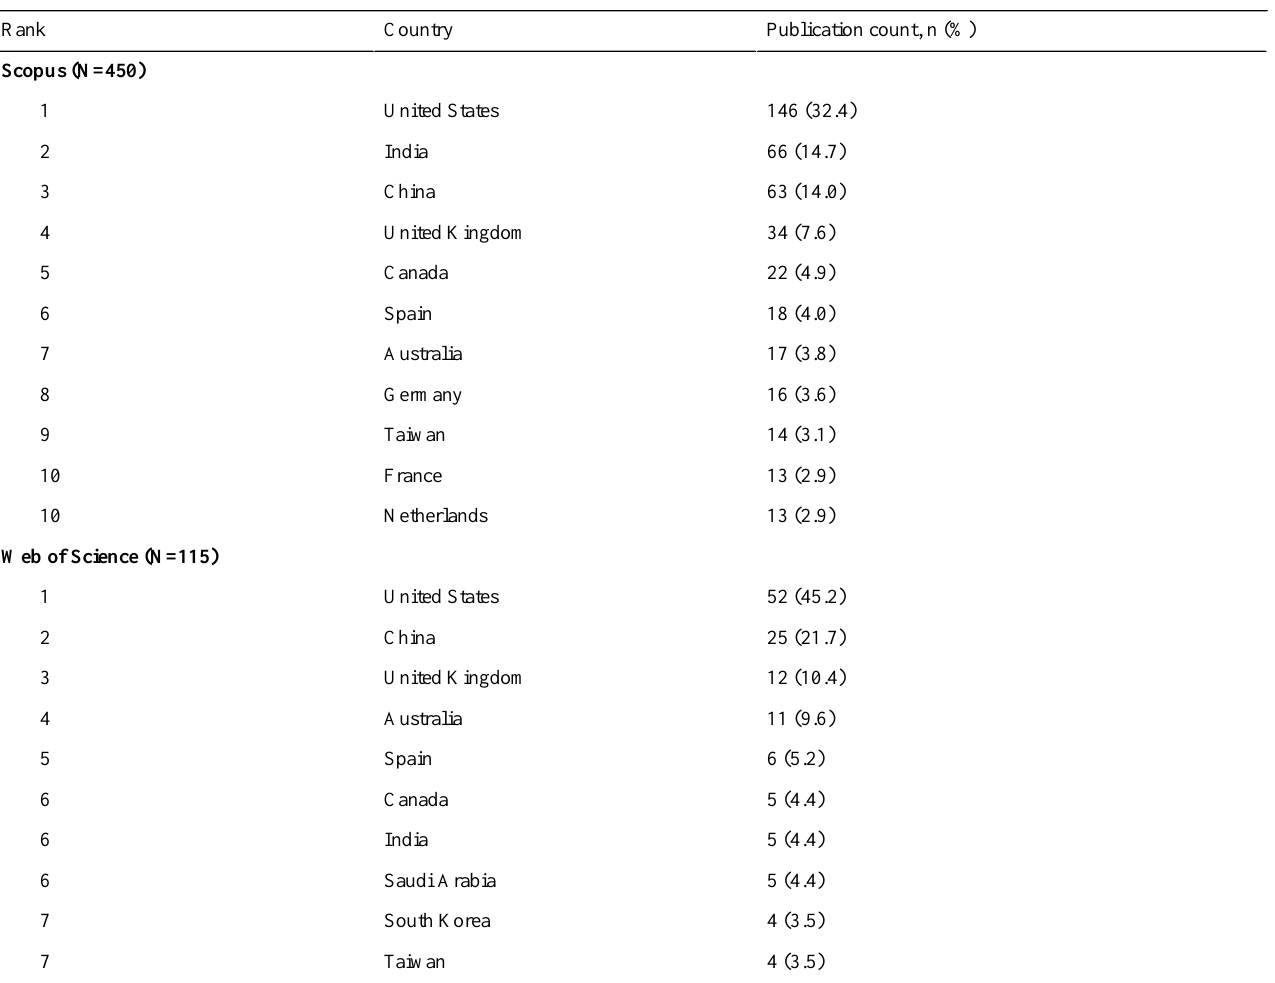
Table 4. Top productive countries.